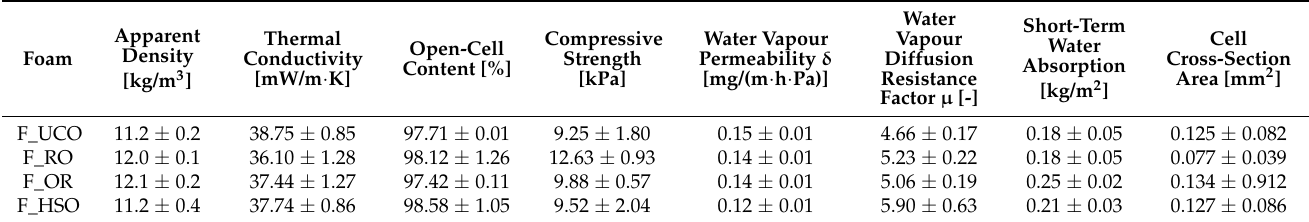
Table 6. Properties of the polyurethane foams.